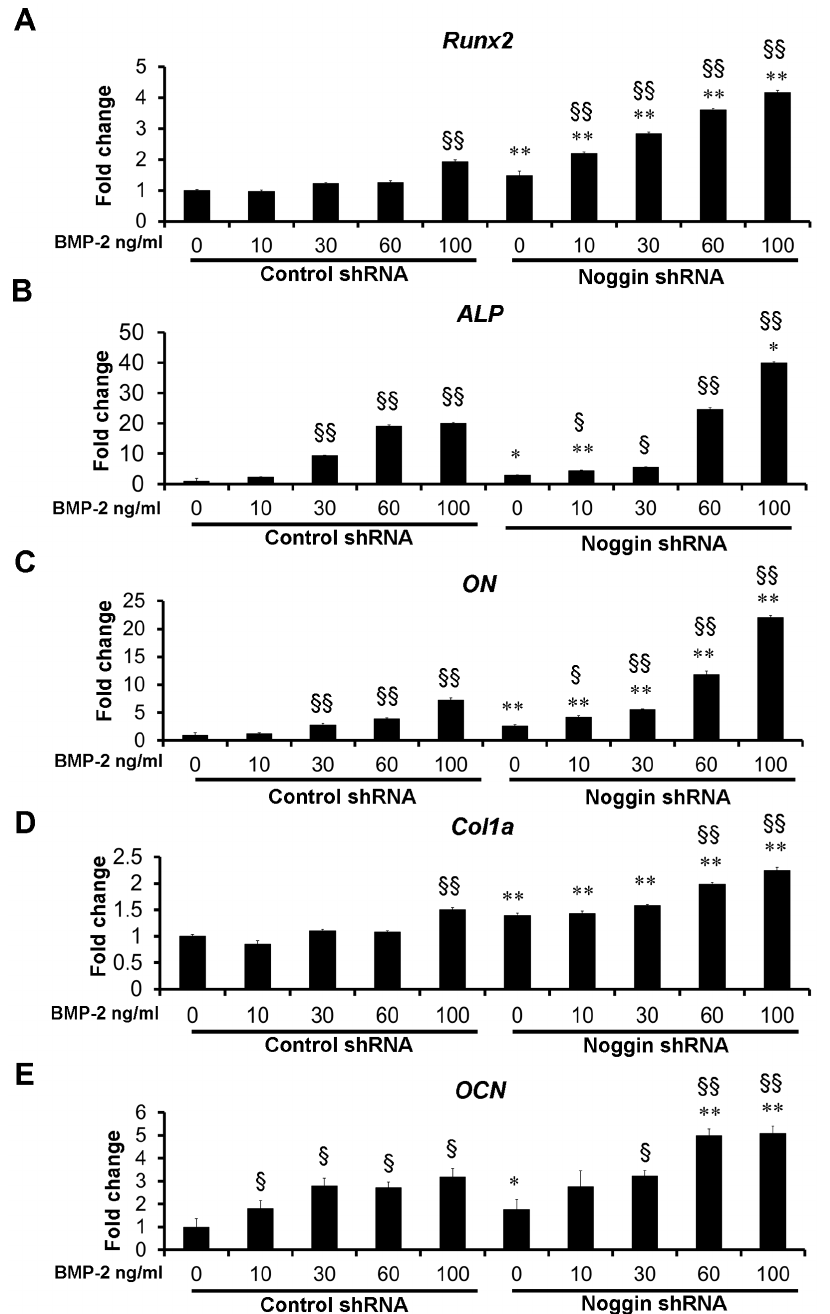
Figure 4. Osteogenic gene expression of ASCs in monolayer culture. Osteogenic gene markers including Runx2 (A), ALP (B), ON (C), Col1a (D) and OCN (E), were elevated in ASCs transduced with noggin shRNA in the presence or absence of BMP-2 as analyzed by quantitative real-time PCR at day 14 (* p , 0.05, ** p , 0.01 compared to their corresponding controls transduced with control shRNA). Significant up-regulation of all genes was observed after treatment with different doses of BMP-2 ( 1 p , 0.05, 11 p , 0.01).